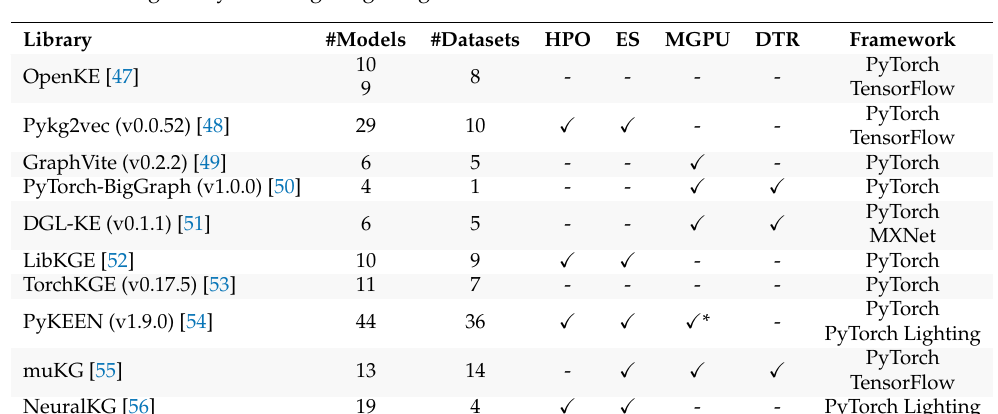
Table 4. An overview of the functionalities offered by central software libraries (determined in September 2022). HPO refers to hyperparameter optimization, ES for early stopping, MGPU for multi-GPUs support, DTR for distributed training, and * indicates that multi-GPUs support is only available using the PyTorch Lighting